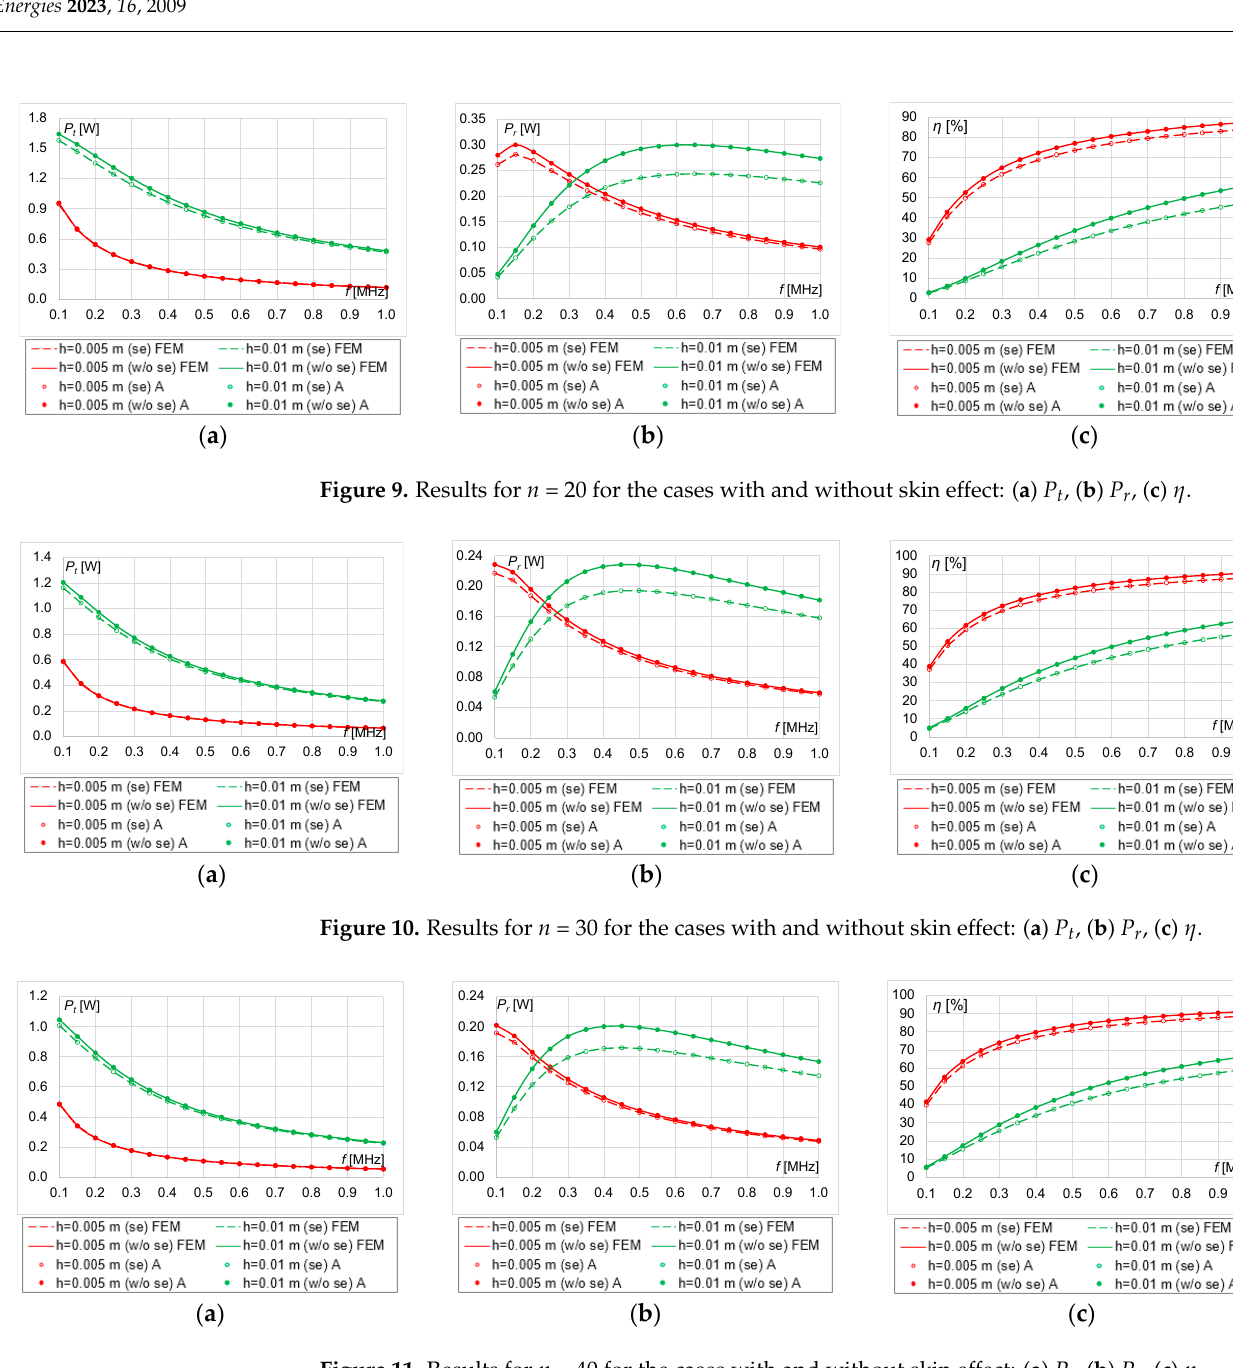
Figure 11. Results for n = 40 for the cases with and without skin effect: ( a ) P t , ( b ) P r , ( c ) η .